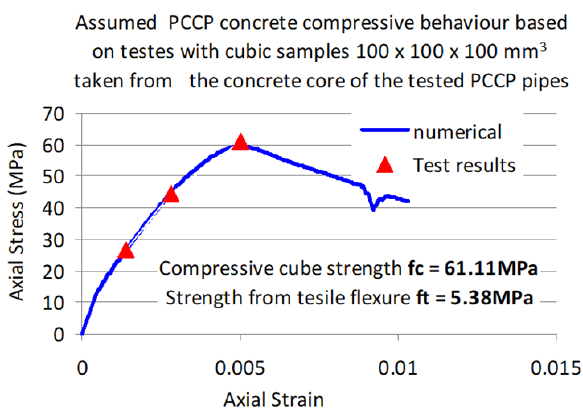
Figure 5. Compressive behaviour of concrete core specimens taken from the tested PCCP pipes.